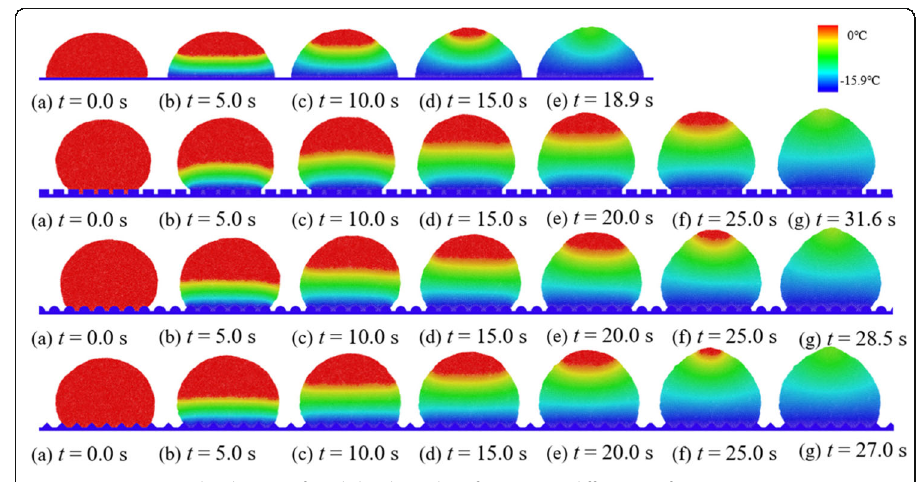
Fig. 9 Temperature distribution of 40ul droplets when freezing on different